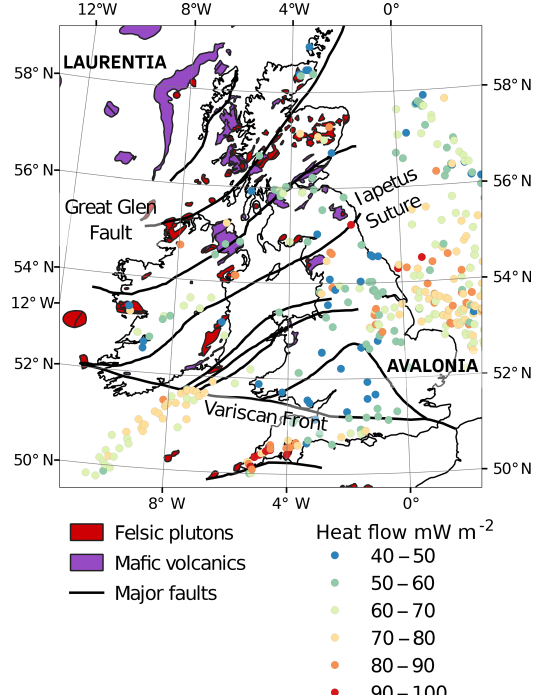
Figure 1. Igneous outcrop and major geological structures across the British Isles. Surface heat flow data are compiled from Mather et al. (2018) and Pollack et al.